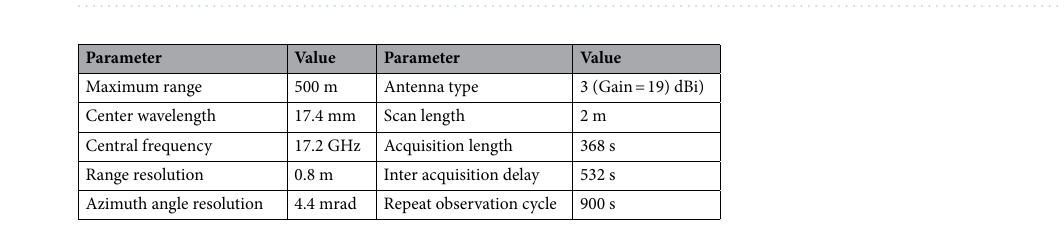
Table 1. GB-SAR measurement parameters used for the